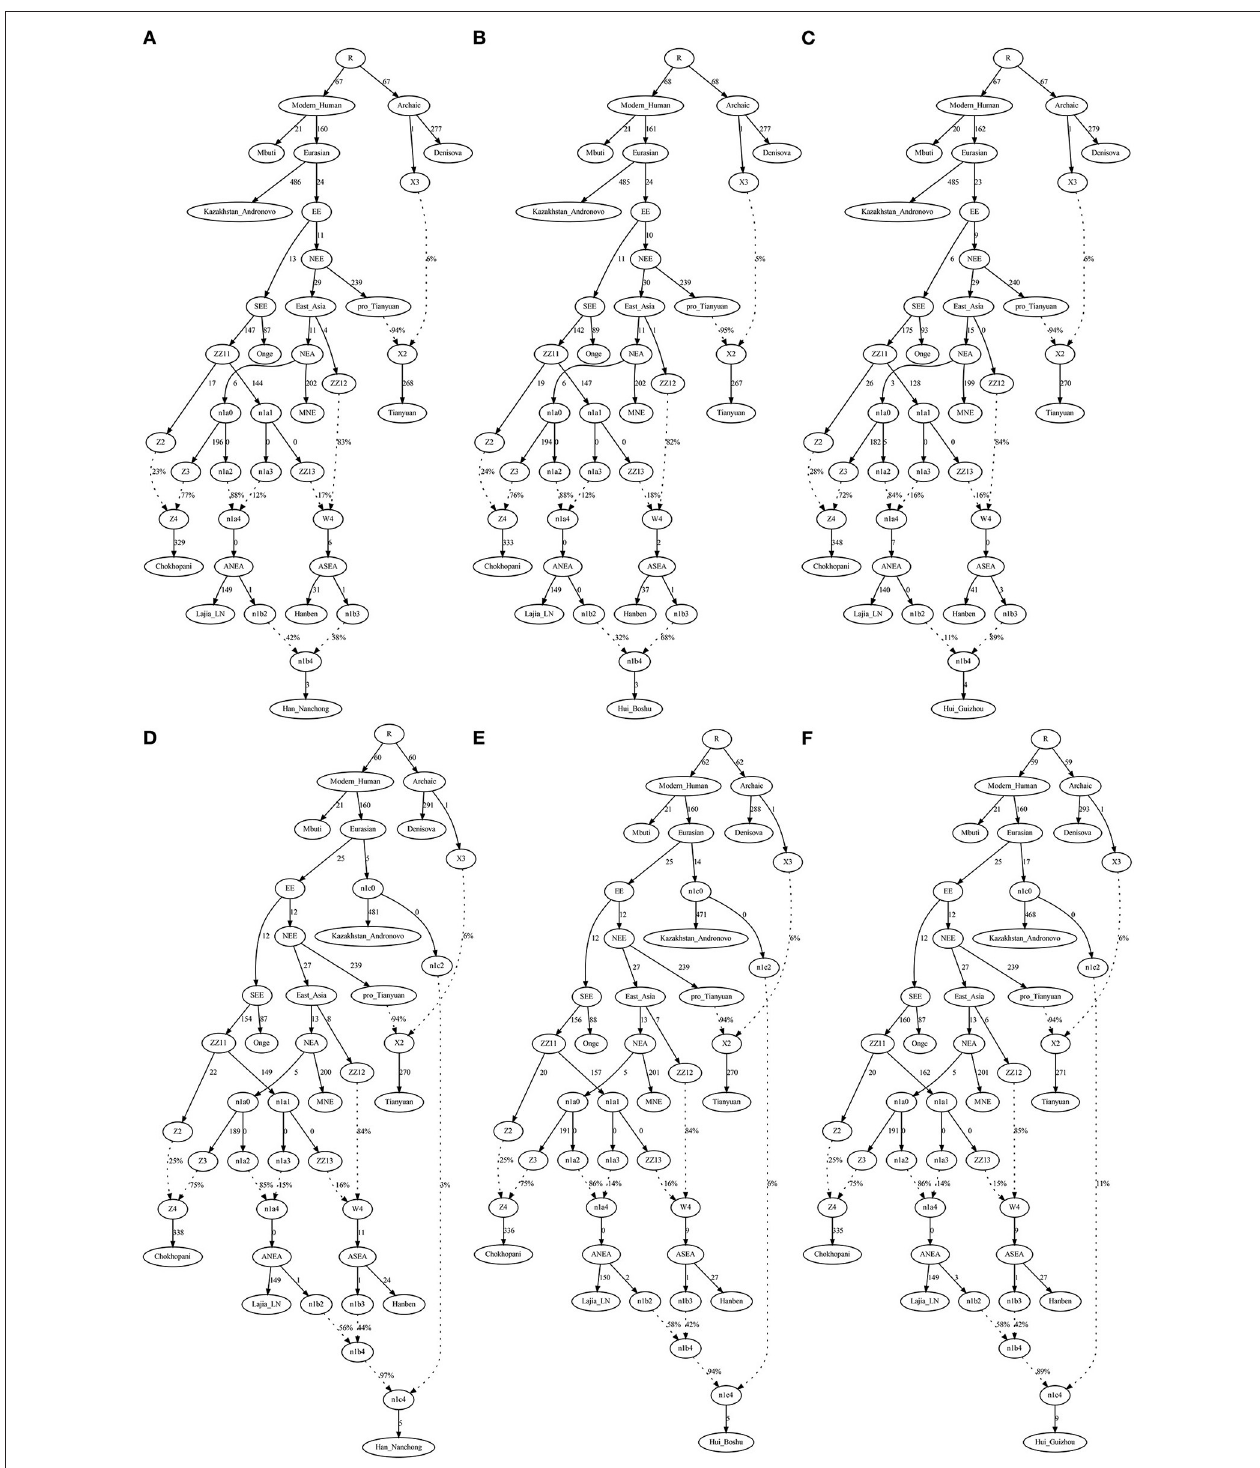
FIGURE 5 | QpGraph -based admixture graphs illustrate that a western gene flow can improve the fitness of the deep genomic model of Chinese Hui. Branch length was marked with the f 2 shared drift distance (1,000 times). Admixture events were denoted as dotted line. The admixture proportion was marked along the dotted 2.417 * SE , Final score: 19.834. (B) f4(Kaz, Tia; Han, Hiu) 2.897 * SE , Final score: 26.782. (C) f4(Kaz, Tia; Han, Hiu) 4.683 * SE , line. (A) f4(Kaz, Tia; MNE, Laj) = = − = − 2.516 * SE , Final score: 18.555. (E) f4(Kaz, Tia; MNE, Laj) 2.487 * SE , Final score: 17.383. (F) f4(Kaz, Tia; MNE, Laj) Final score: 53.444. (D) f4(Kaz, Tia; MNE, Laj) = = 2.488 * SE , Final score: 17.994. EBA, Early Bronze Age; LN, Late Neolithic; N, Neolithic. =